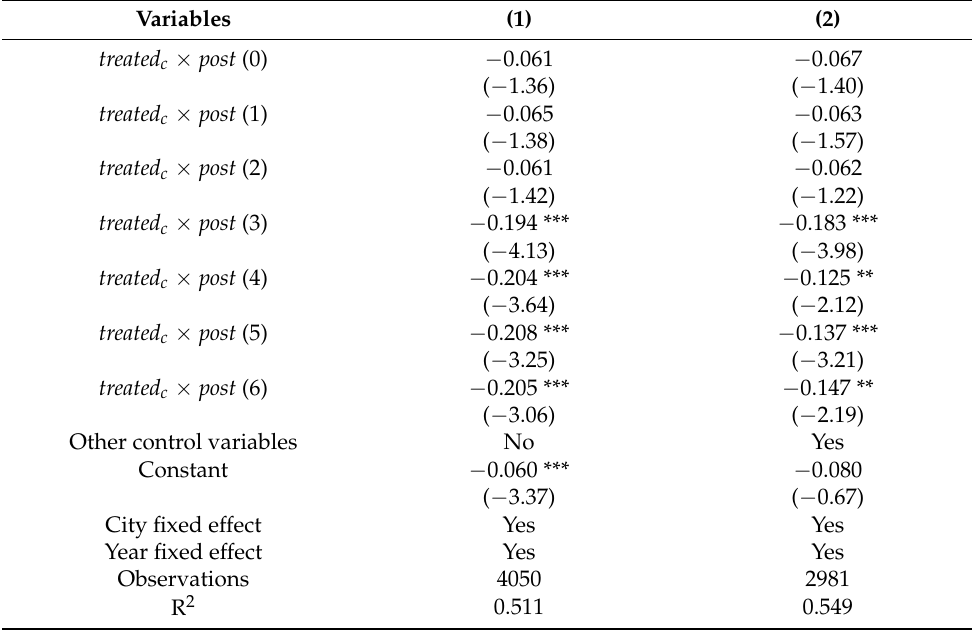
Table 3. Regression results of dynamic effects on energy